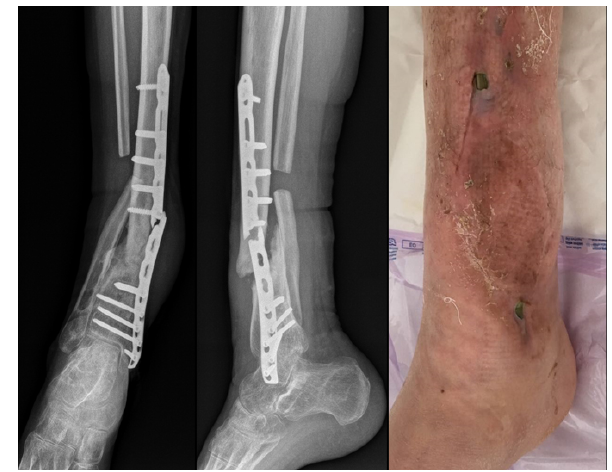
Figure 3. Follow-up X-ray during bone lengthening, after debride- ment, in CFRI case